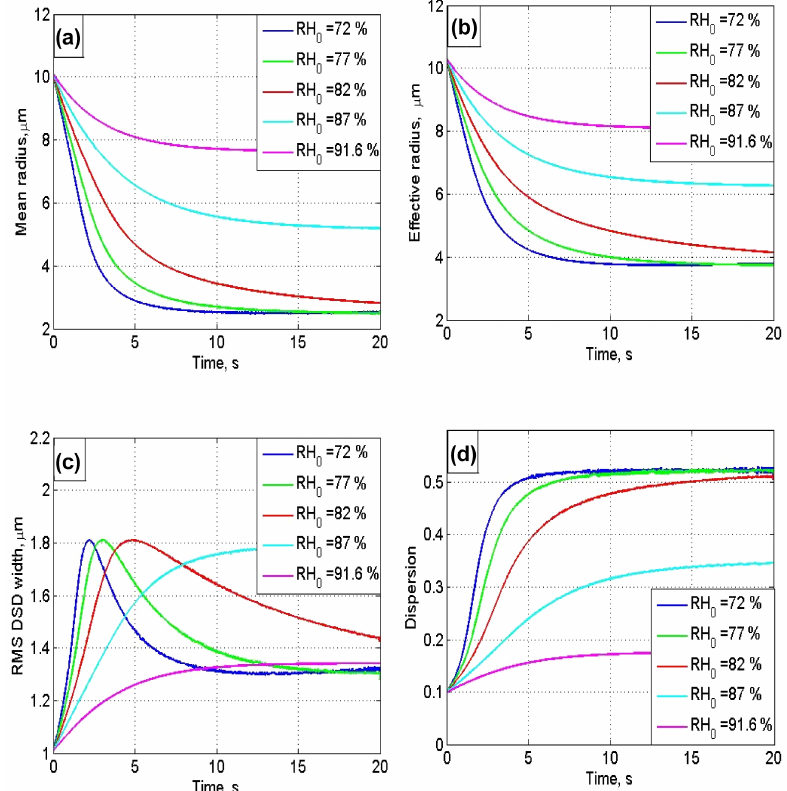
Figure 9. Dependencies of moment functions typically used for characterizing DSD shape at different values of the initial relative humidity RH 0 in the resulting volume. The dependencies are calculated using a parcel model for an initially narrow DSD (Table 3). The thermodynamic parameters are the same as in Fig.